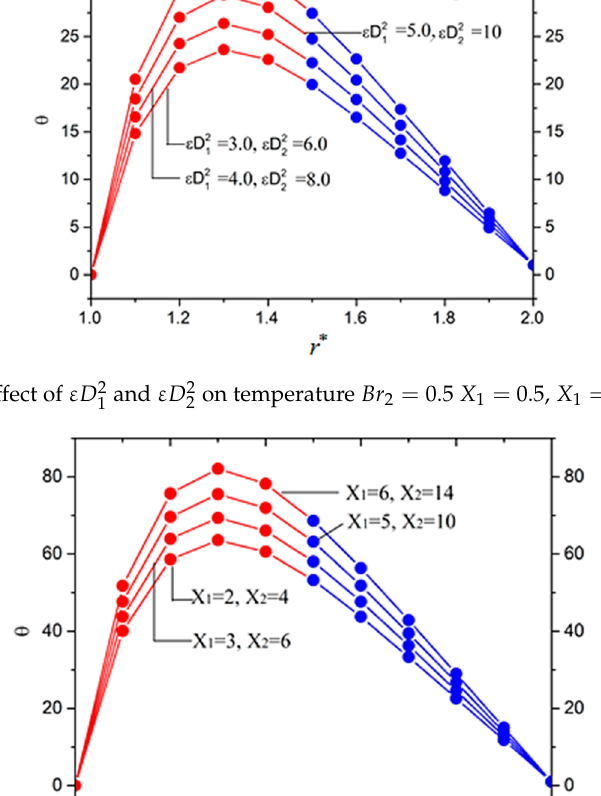
Figure 7. Effect of 𝐵𝑟 (cid:2869) and 𝐵𝑟 (cid:2870) on temperature 𝑋 (cid:2869) = 0.5, 𝑋 (cid:2869) = 1.0 , ε𝐷 (cid:2870)(cid:2870) = 10 , δ = 2 .